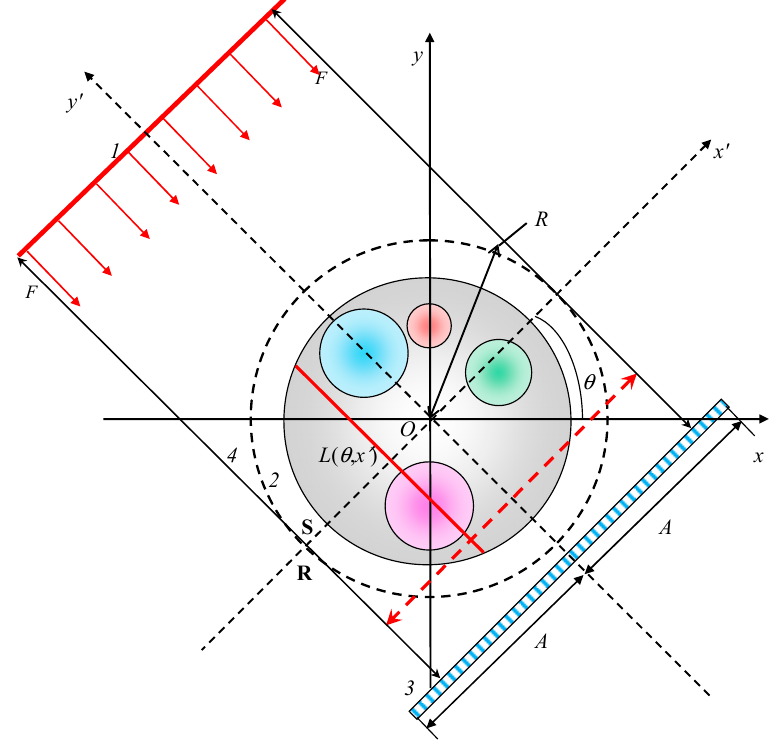
Figure 1. Scheme of projection formation in X-ray CT in parallel beam geometry: 1 —photon radiation source; 2 —test object; 3 —detector array; 4 —a circle describing the test object section.